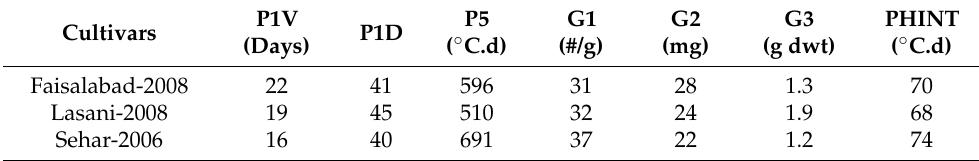
Table 1. Genetic coefficients under CERES-Wheat used for model calibration. Cultivars